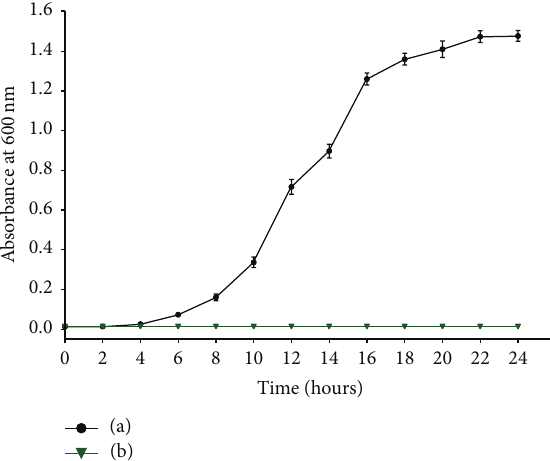
Figure 3: Growth of Bacillus subtilis strain PA-2 in (a) tryptone soy broth and (b) tryptone soy broth containing 100mM 4C2NP or 100 mM 4NP or 100mM